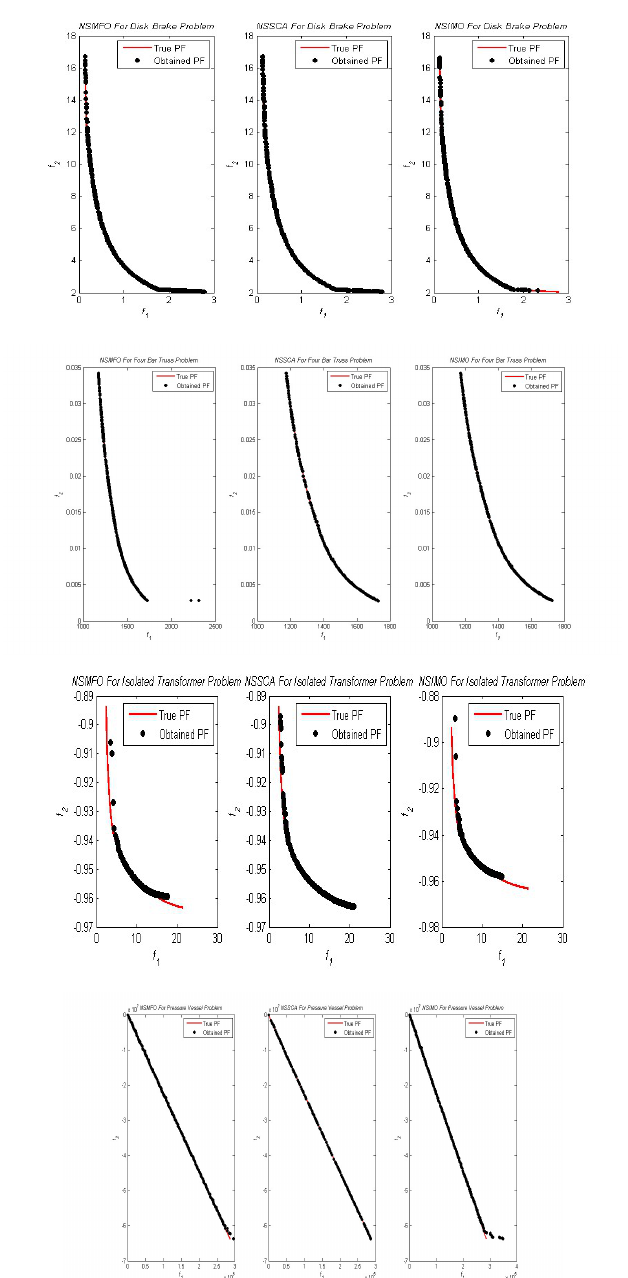
Fig. 8. Best Pareto optimal front of SRN, CONSTR, OSY, CF1, BEL, and BNH obtained by the NSMFO, NSSCA, and